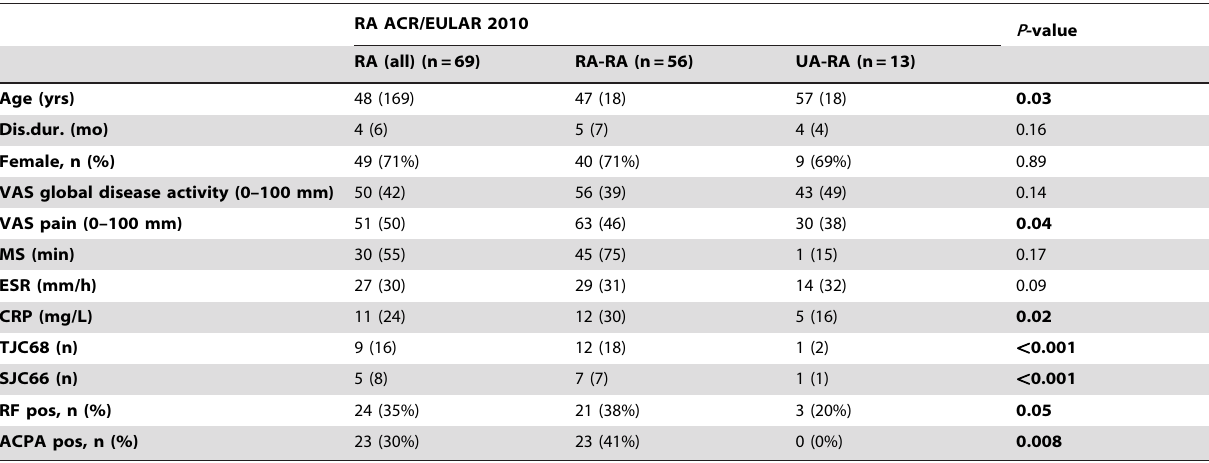
Table 1. Baseline patient characteristics.